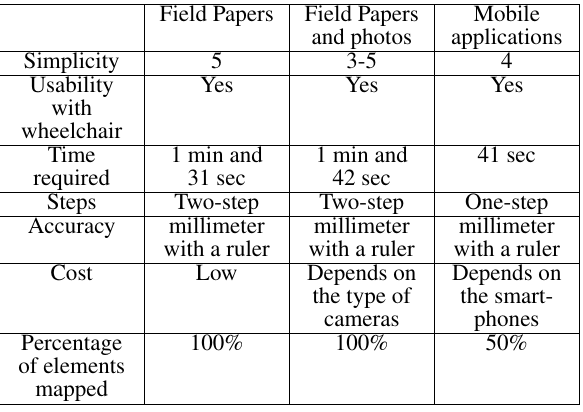
Table 1. Comparison of the